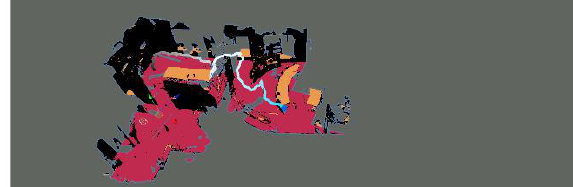
Figure 5: Tracking representation. The left part of the model has been scanned while the right part of the model is not yet scanned.